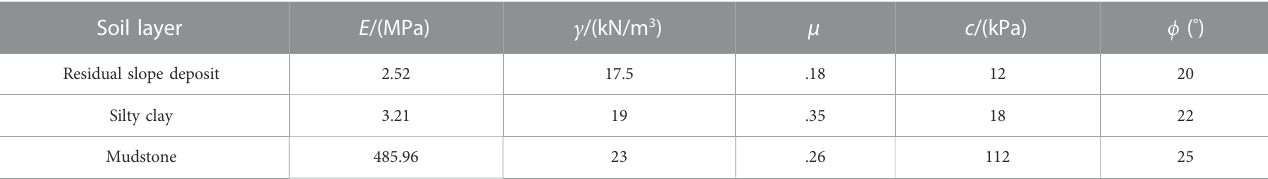
TABLE 1 Geotechnical